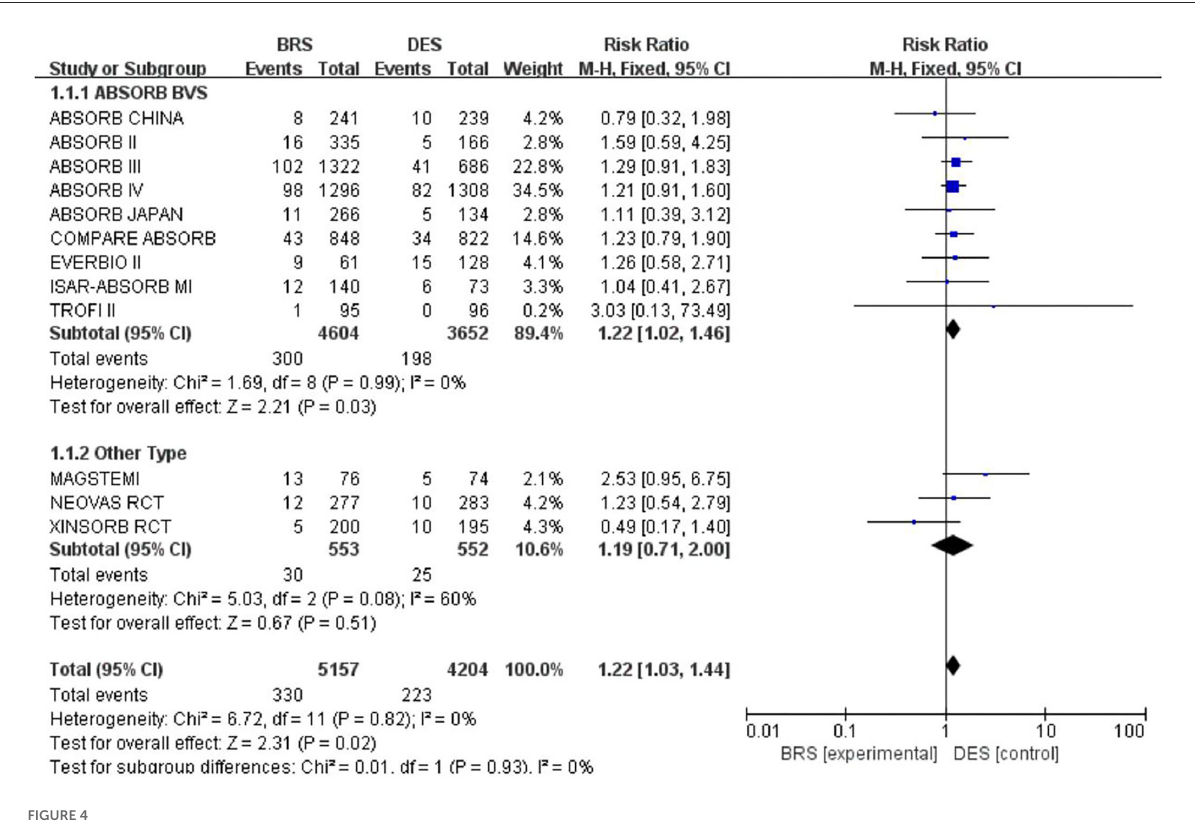
FIGURE4 Meta-analysis results of forest plots for